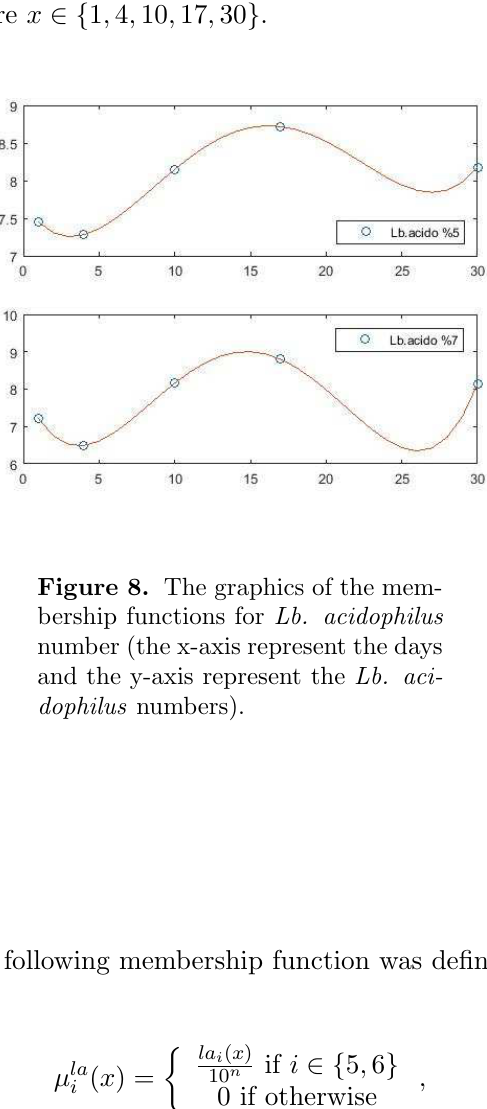
Figure 7. The graphics of the mem- bership functions for Lb. casei num- ber (the x-axis represent the days and the y-axis represent the Lb.